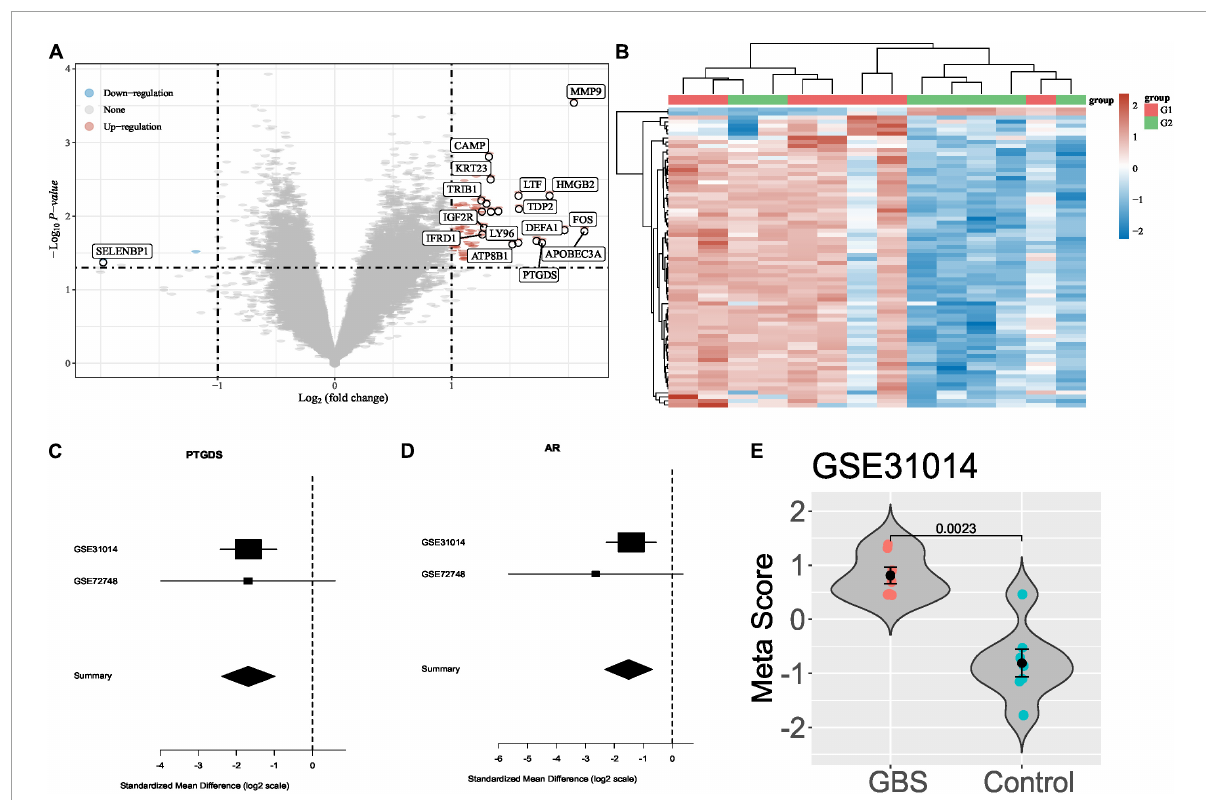
FIGURE1 Differential gene expression analysis of GBS. (A,B) Differentially expressed genes between GBS and controls in GSE31014; (C,D) forest plots of PTGDS and AR gene in GSE31014 and GSE72748; (E) violin plot showing the performance of the 2-gene signature for separating GBS from control in GSE31014.